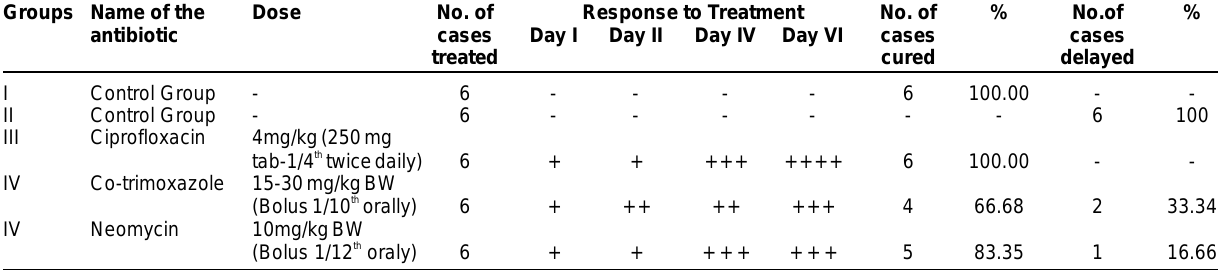
Table-2. Therapeutic trials in clinical cases of colibacillosis in lambs Groups Name of